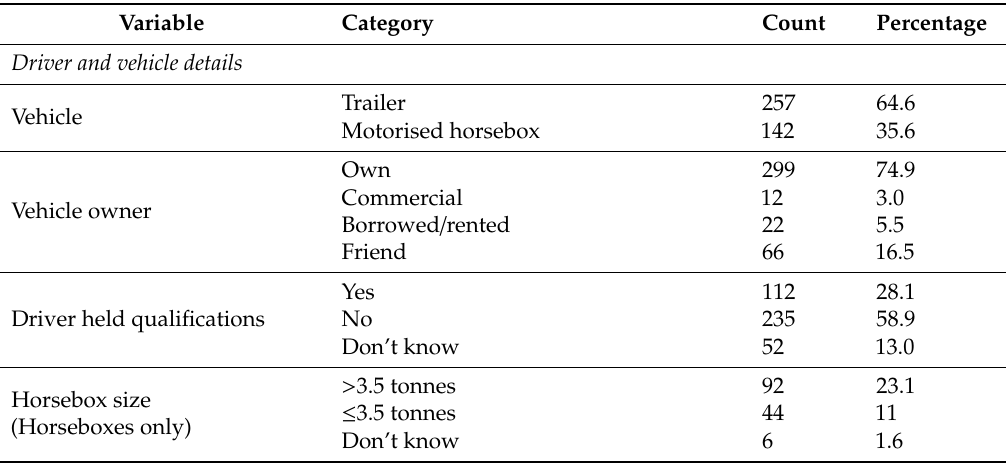
Table 8. Frequency table for incident details (count and percentages for incident-specific driver and vehicle details, journey details and incident characteristics) for the 399 incidents